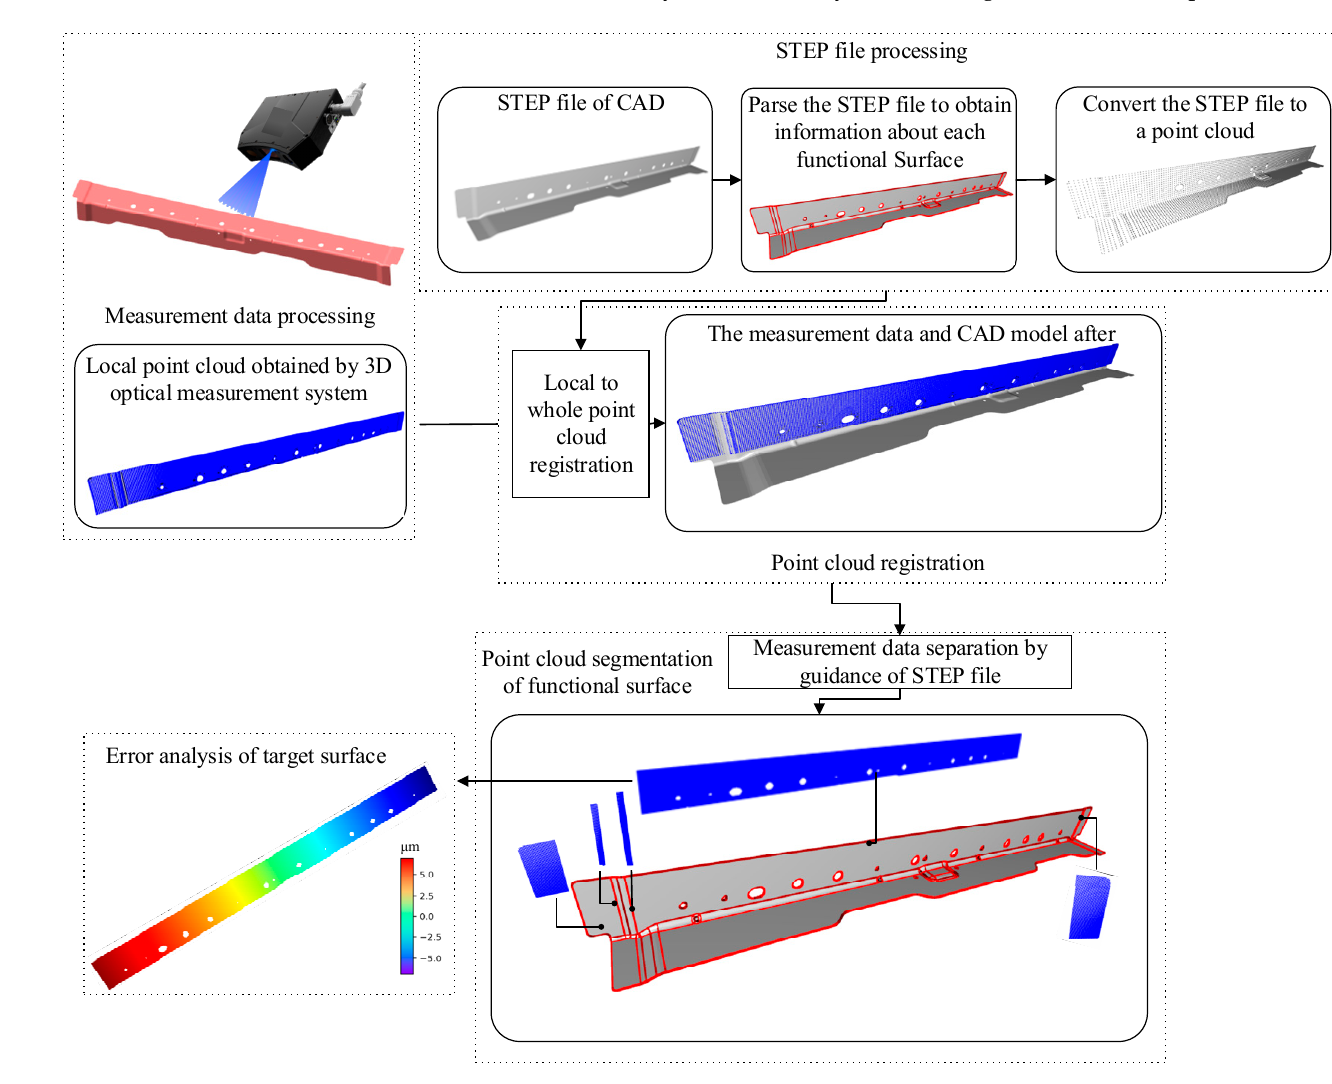
Figure 1. Th e flowchart of surface topography analysis ( μ m). Figure 1. The flowchart of surface topography analysis ( µ